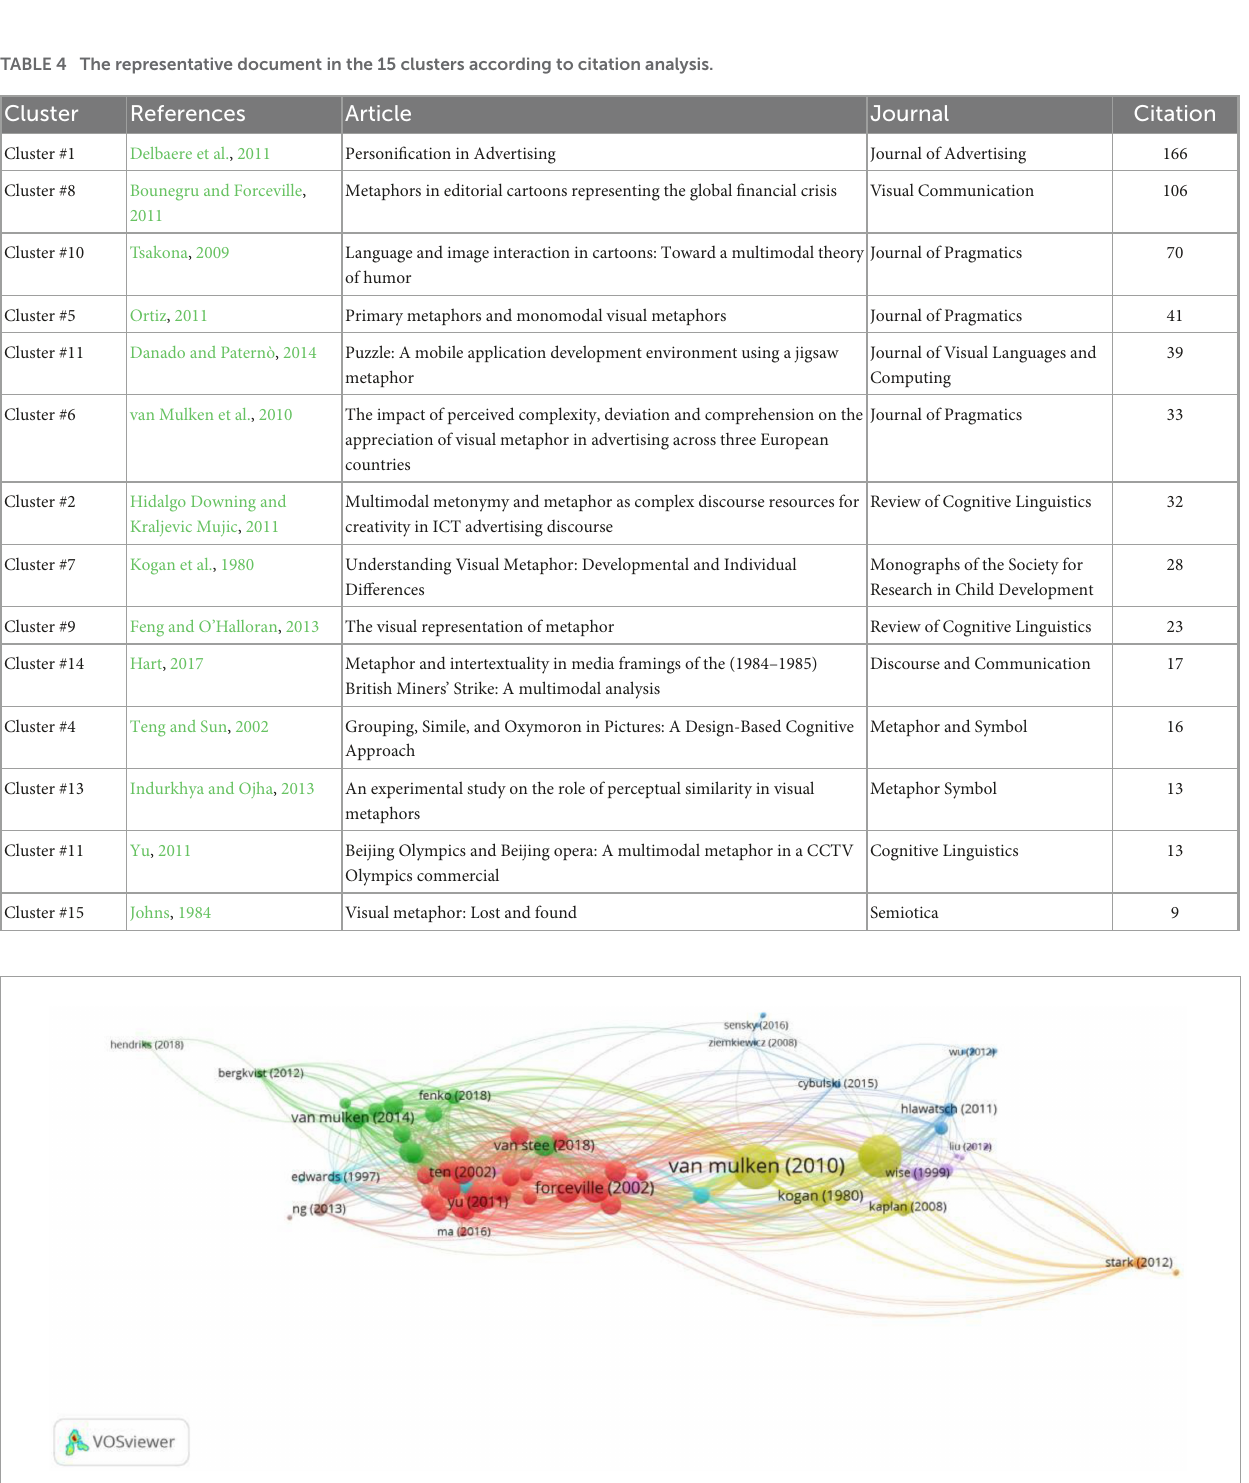
FIGURE9 VOSviewer network map showing the bibliographic coupling of documents (min number of citations of a document = 9; visualization by weight of total link